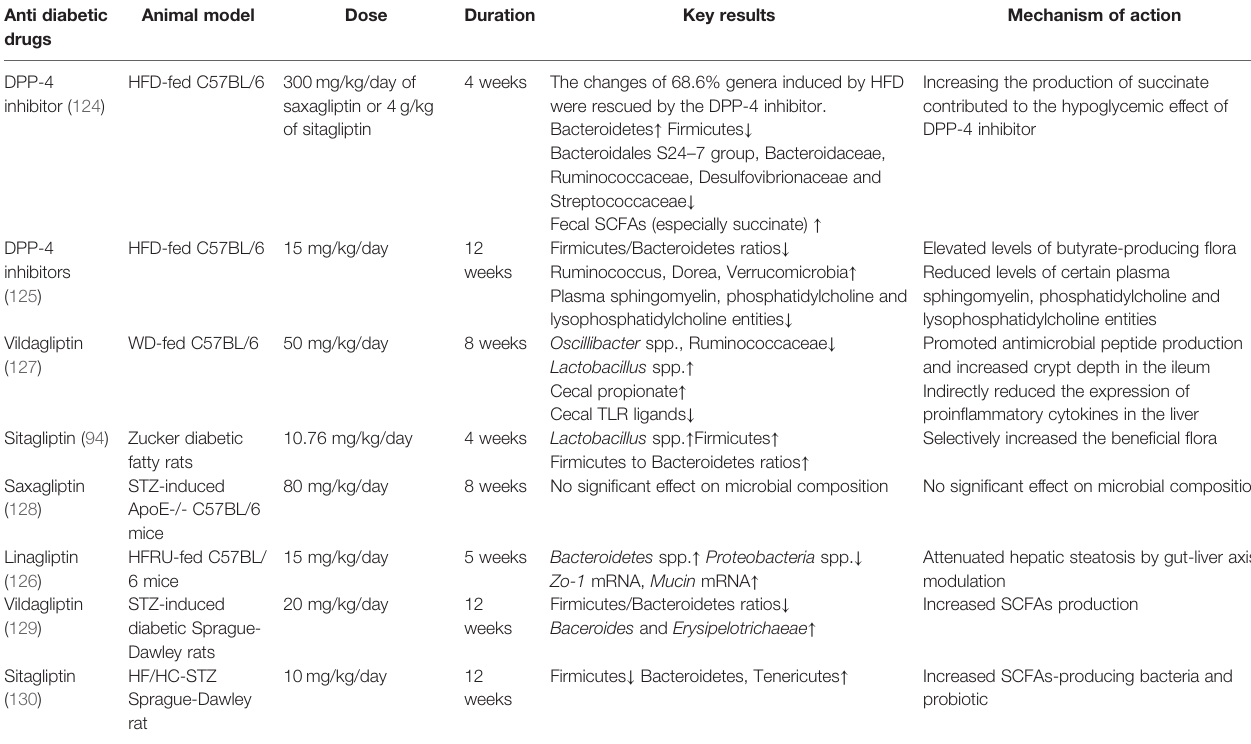
TABLE 3 | Experimental animal studies analyzing the effects of DPP-4 inhibitors on gut microbiota. Anti diabetic Animal drugs